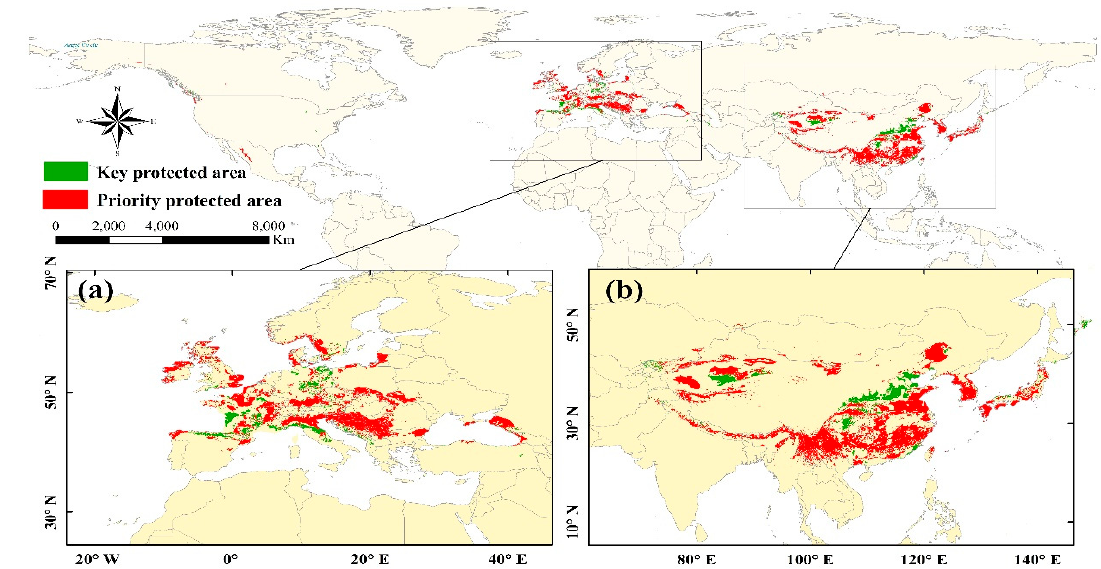
Figure 8. Identification of the priority protected areas and the key protected areas of M. which are mainly in Europe ( a ) and in East Asia ( b glyptostroboides, which are mainly in Europe ( a ) and in East Asia ( b ).